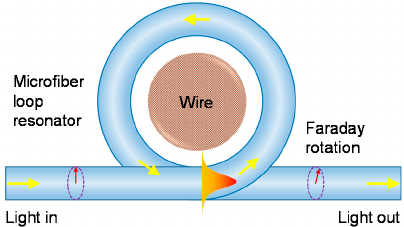
Figure 11. Schematic diagram of a microfiber loop resonator-based sensor for current sensing. The directions of light propagation and mode coupling are shown as arrows. The arrows in dashed-circles represent the Faraday rotation. The horizontal peak illustrates the intensity distribution.